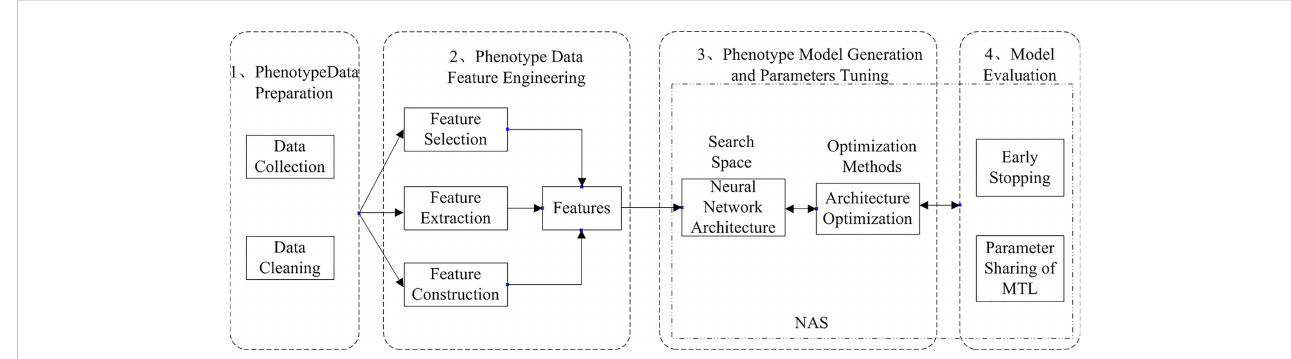
FIGURE 2 Work fl ow of Arabidopsis thaliana phenotype analysis based on automated multi-task machine learning (He et al.,